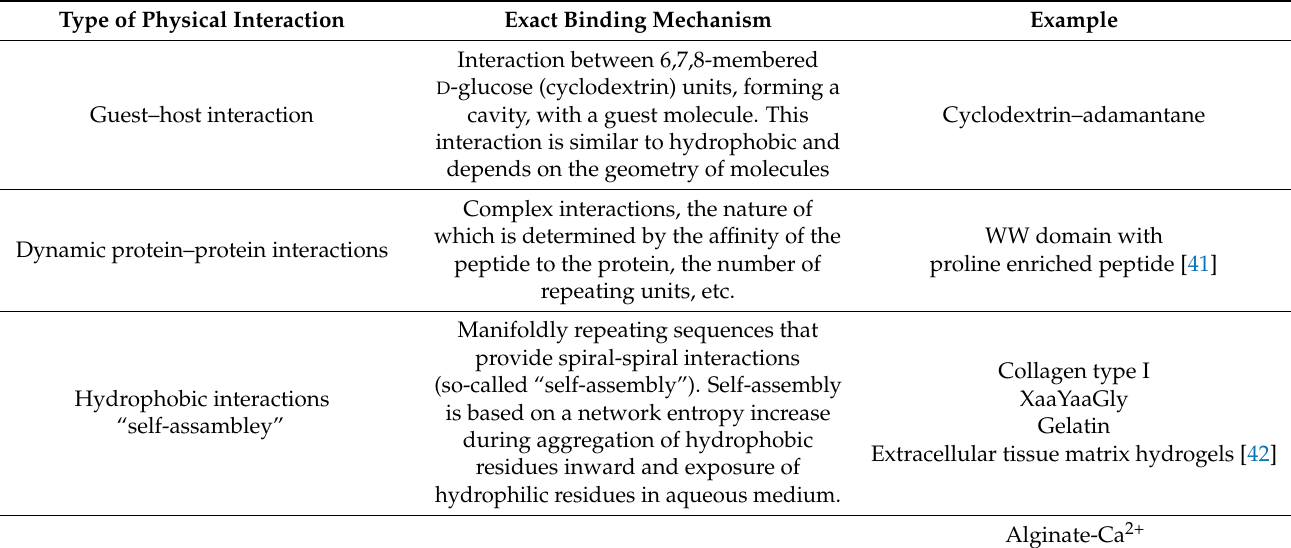
Table 2. The main physical interaction used for hydrogel polymerization (from C.Echalier et al., 2019